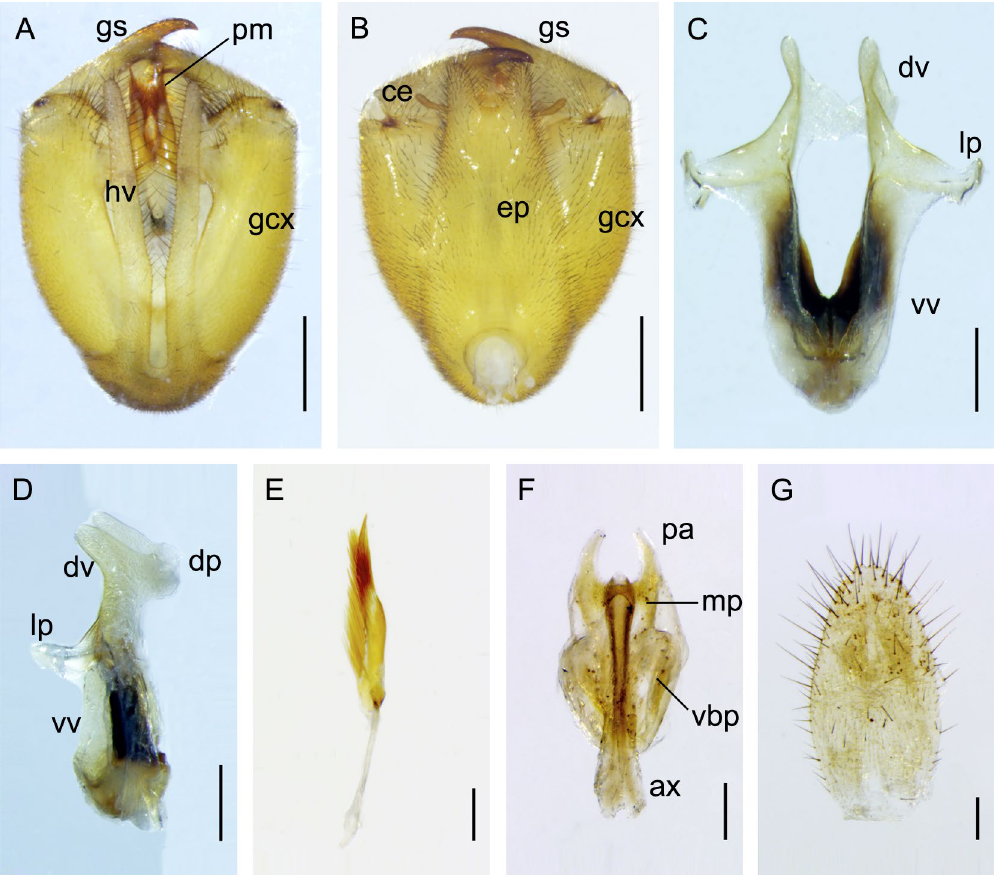
Fig. 12. Genitalia of Cerapanorpa yanggashana sp. nov. A–B . Male genital bulb in ventral and dorsal views. C–D . Aedeagus in ventral and lateral views. E . Left paramere in lateral view. F . Female medigynium in ventral view. G . Female subgenital plate in ventral view. Abbreviations: ax = axis; ce = cercus; dp = dorsal process; dv = dorsal valve; ep = epandrium; gcx = gonocoxite; gs = gonostylus; hv = hypovalve; lp = lateral process; mp = main plate; pa = posterior arm; pm = paramere; vbp = ventral basal plate; vv = ventral valve. Scale bars: A–B = 0.5 mm; C–G = 0.2